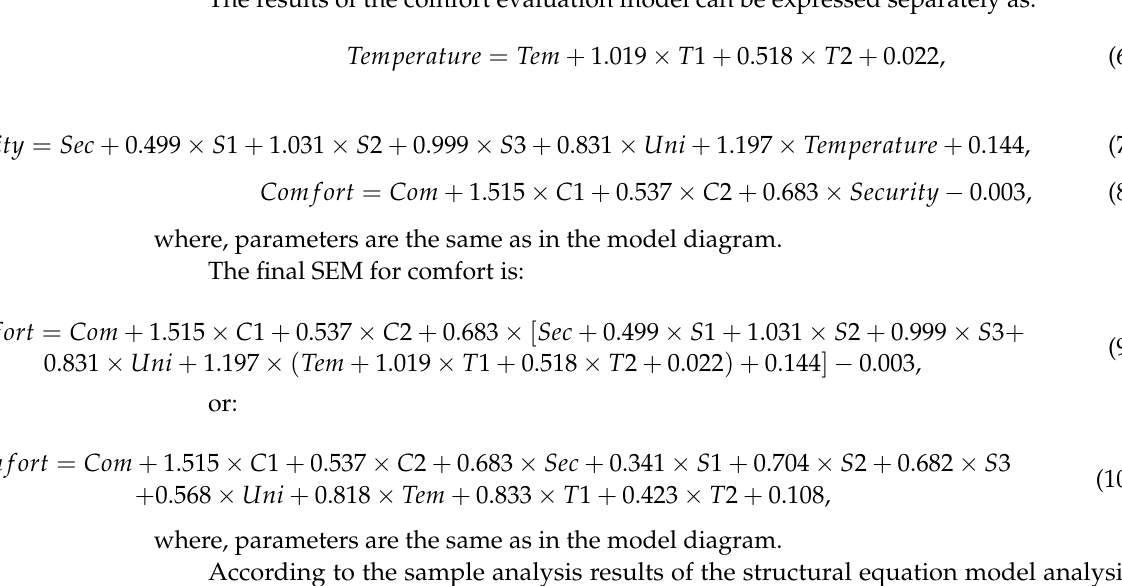
Figure 15. Comfort evaluation model of public space lighting in typical residential areas of Beijing.